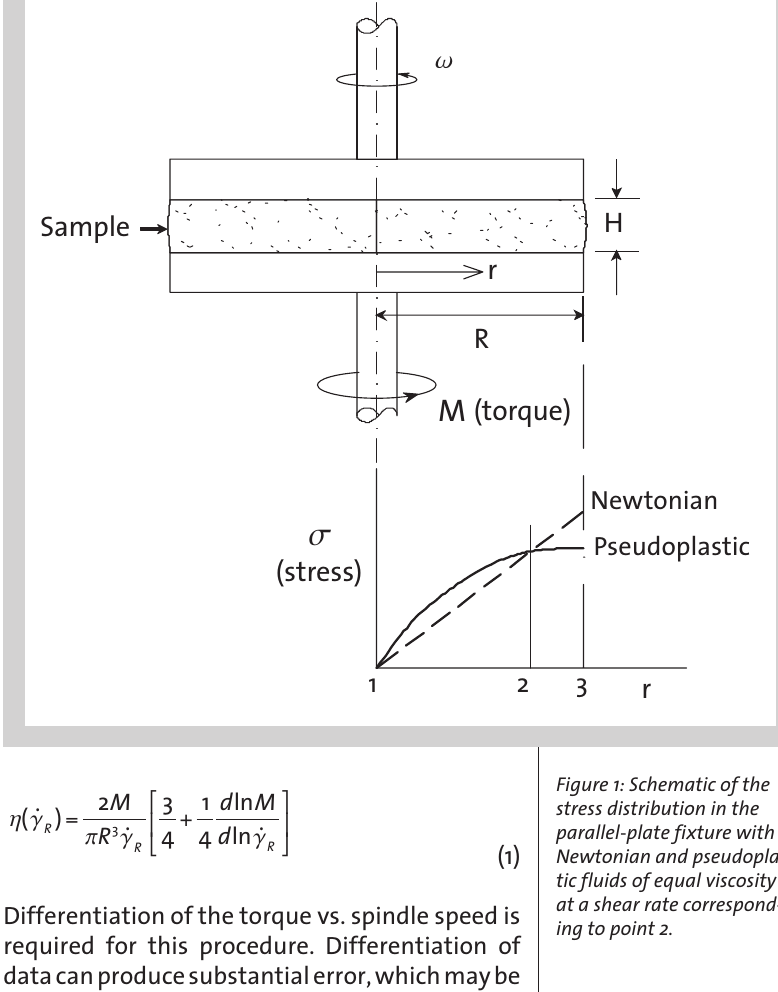
Figure 1: Schematic of the stress distribution in the parallel-plate fixture with Newtonian and pseudoplas- tic fluids of equal viscosity at a shear rate correspond- ing to point